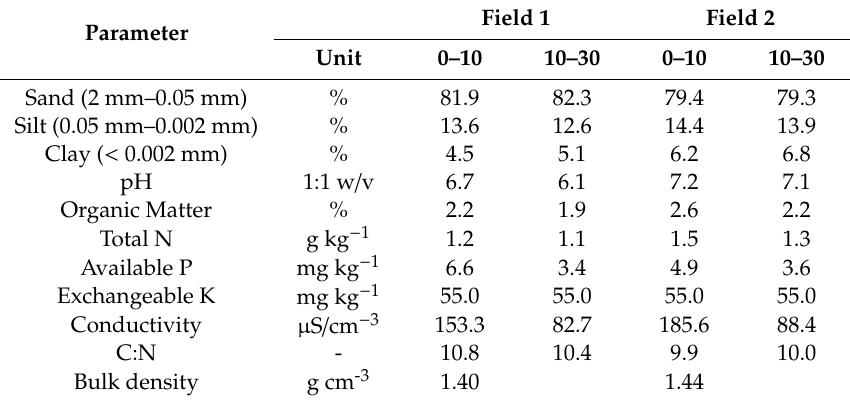
Table 1. Characterization of soil in the two fields (F1, F2) and at two depths (0–10 cm, 10–30 cm).